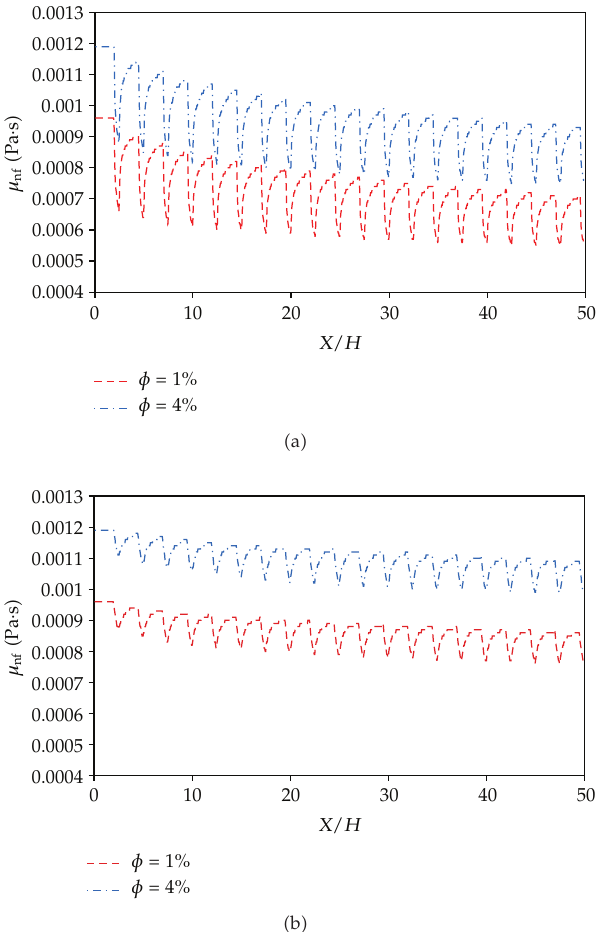
Figure 7: E ff ect of particle loading parameter φ on nanofluid viscosity along the channel for: (cid:3) a (cid:5) Re (cid:4) 50, (cid:3) b (cid:5) Re (cid:4)